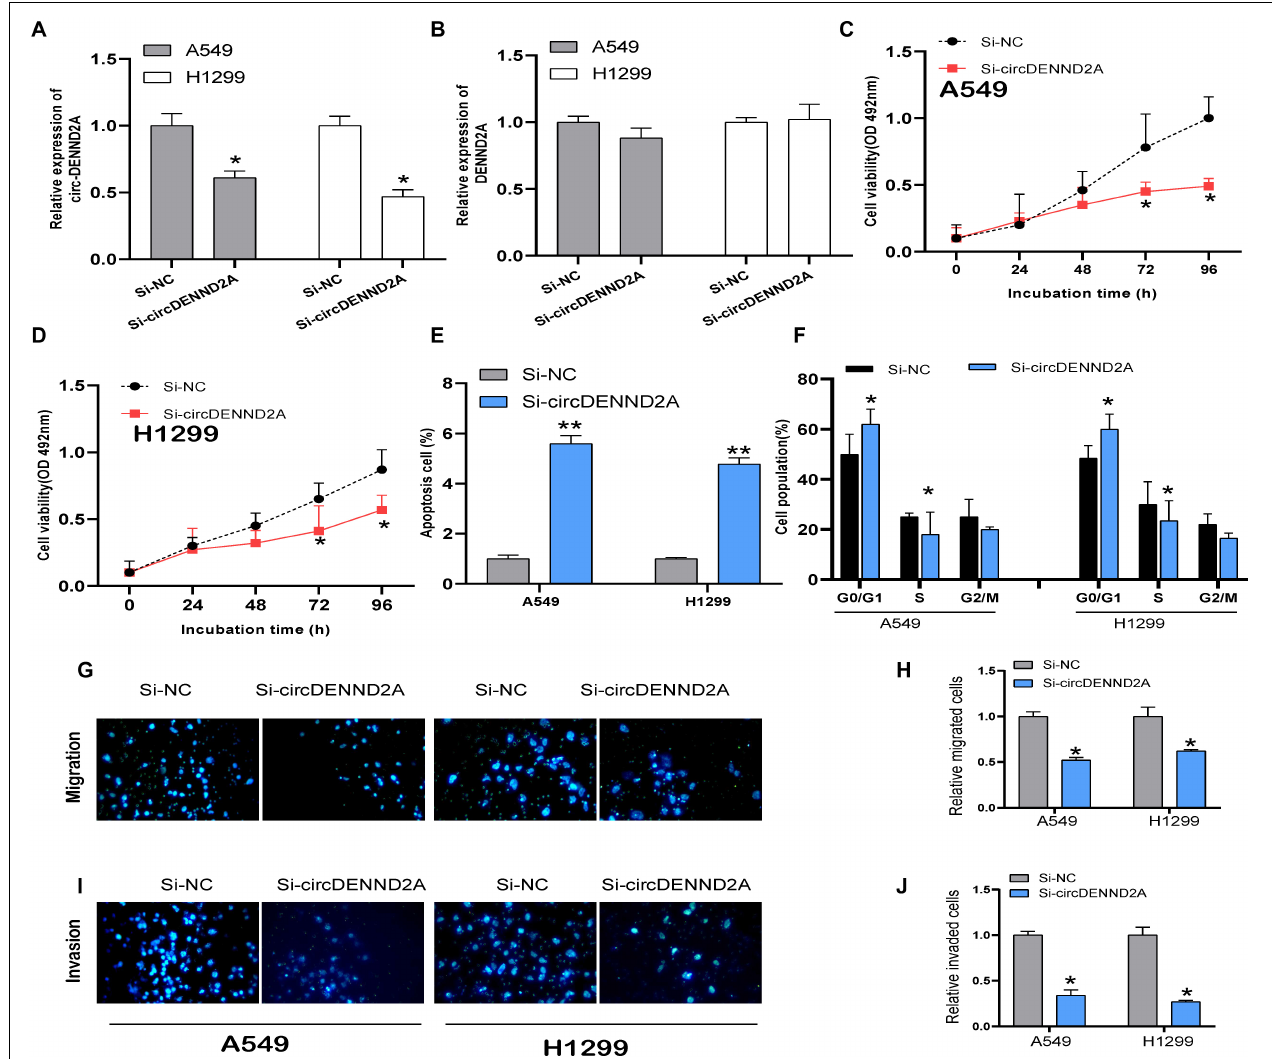
FIGURE 2 | CircDENND2A promoted tumorigenesis in NSCLC cells. (A,B) Expression of circDENND2A and DENND2A was confirmed by qRT-PCR in A549 and H1299 cells transfected with Si-NC or Si-circDENND2A. (C,D) Knockdown of circDENND2A significantly inhibited cell proliferation of A549 (C) and H1299 (D) cells by CCK-8 assay. (E) Cell apoptosis was determined by flow cytometry in A549 and H1299 cells transfected with Si-NC or Si-circDENND2A. (F) Cell cycle was determined by flow cytometry in A549 and H1299 cells transfected with Si-NC or Si-circDENND2A. (G–J) Transwell assay was used to detect the migration and invasion of A549 (G,H) and H1299 (I,J) cells transfected with Si-NC or Si-circDENND2A. Our data were represented as mean ± SD (standard deviation) (* P < 0.05, ** P < 0.01). NSCLC, non-small cell lung cancer; CCK-8, Cell Counting